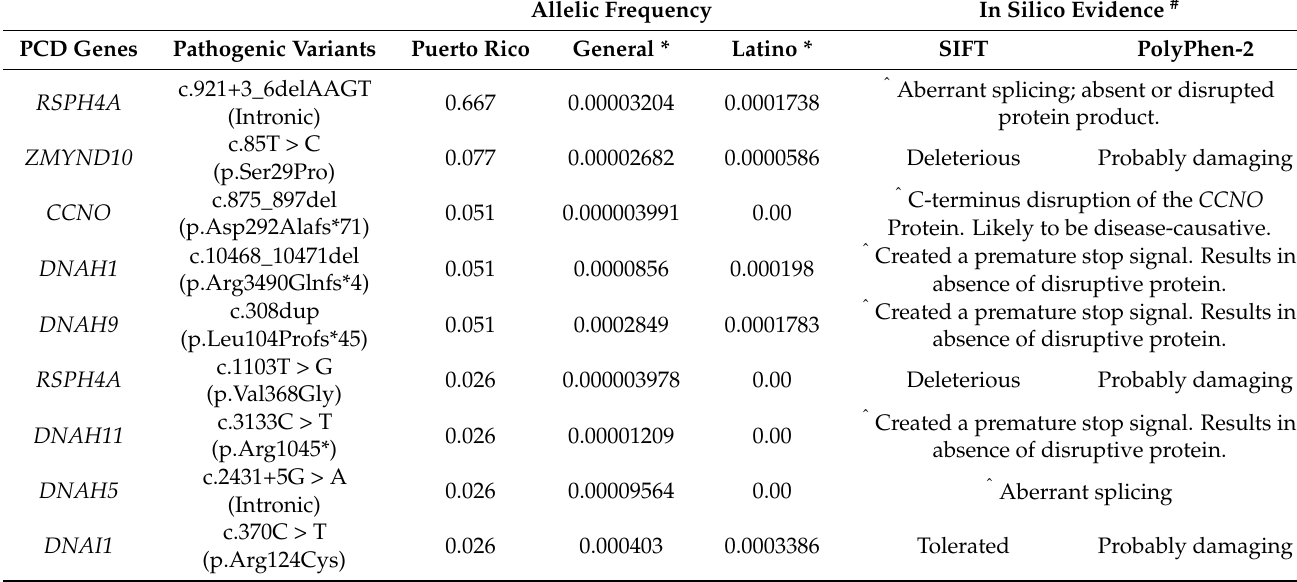
Table 1. Frequency of PCD genes with pathogenic variants found in Puerto Rico. Allelic Frequency